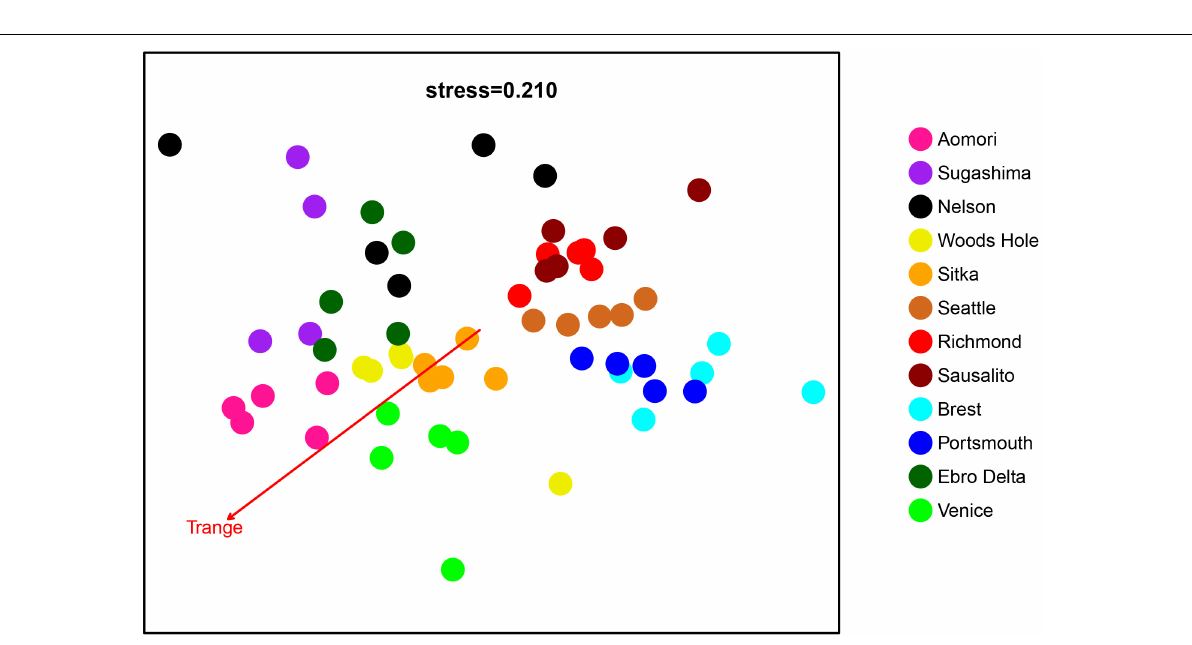
Frontiers in Marine Science |